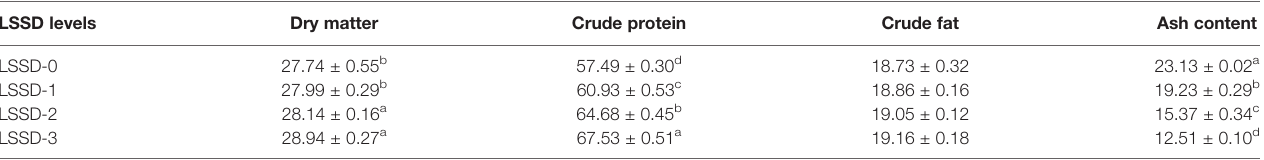
TABLE 4 | Biochemical composition of O. niloticus (%, dry weight basis) fed 0, 1, 2, and 3% diet of L. siceraria seeds supplemented diets